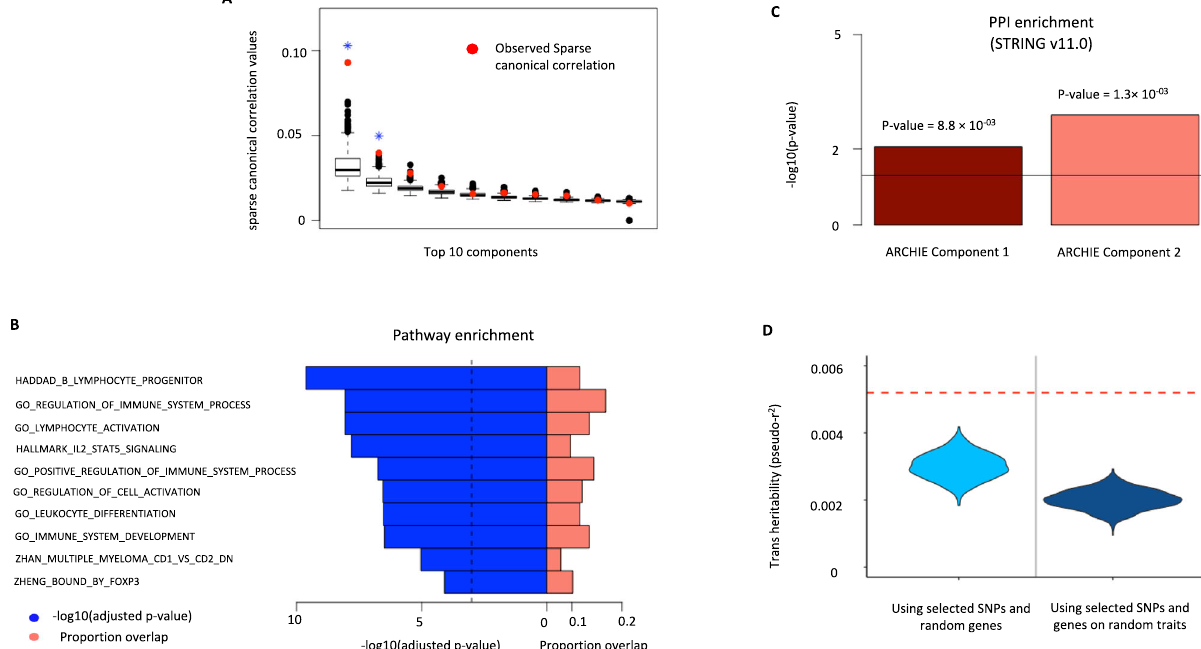
Fig. 4 Analysis of selected target gene-set for Ulcerative Colitis (UC). A Top 10 cc-values (red) and the corresponding competitive null distributions (black box plot) for ARCHIE analysis of UC. Top 2 ARCHIE components are signi fi cant. The box plot for competitive null distribution is presented as ±1.5 interquartile range with the median line denoted at the center. The competitive null distribution denotes the general pattern of sparse canonical correlation (and trans-associations) expected in analysis of variants that are not speci fi c to UC. The signi fi cant ARCHIE components are marked by a blue asterisk. B Pathway enrichment results (one sided test) for some selected top pathways for the selected target genes. The dashed vertical line corresponds to a suggested FDR threshold of 0.001. For full pathway enrichment results for the target genes selected for both the components see Supplementary Data 5 – 7. C PPI enrichment (one sided test) for the two signi fi cant ARCHIE components for UC. D trans-heritability enrichment analysis for target genes selected for UC. The violin plots represent the distribution of pseudo-r 2 for the selected SNPs and a random gene-set of the same size on UC (left) and the distribution of pseudo-r 2 of the selected genes and SNPs on a random trait in UK Biobank (right). The red dashed line represents the observed pseudo-r 2 for the selected SNPs and target genes for UC (See Results and Methods for